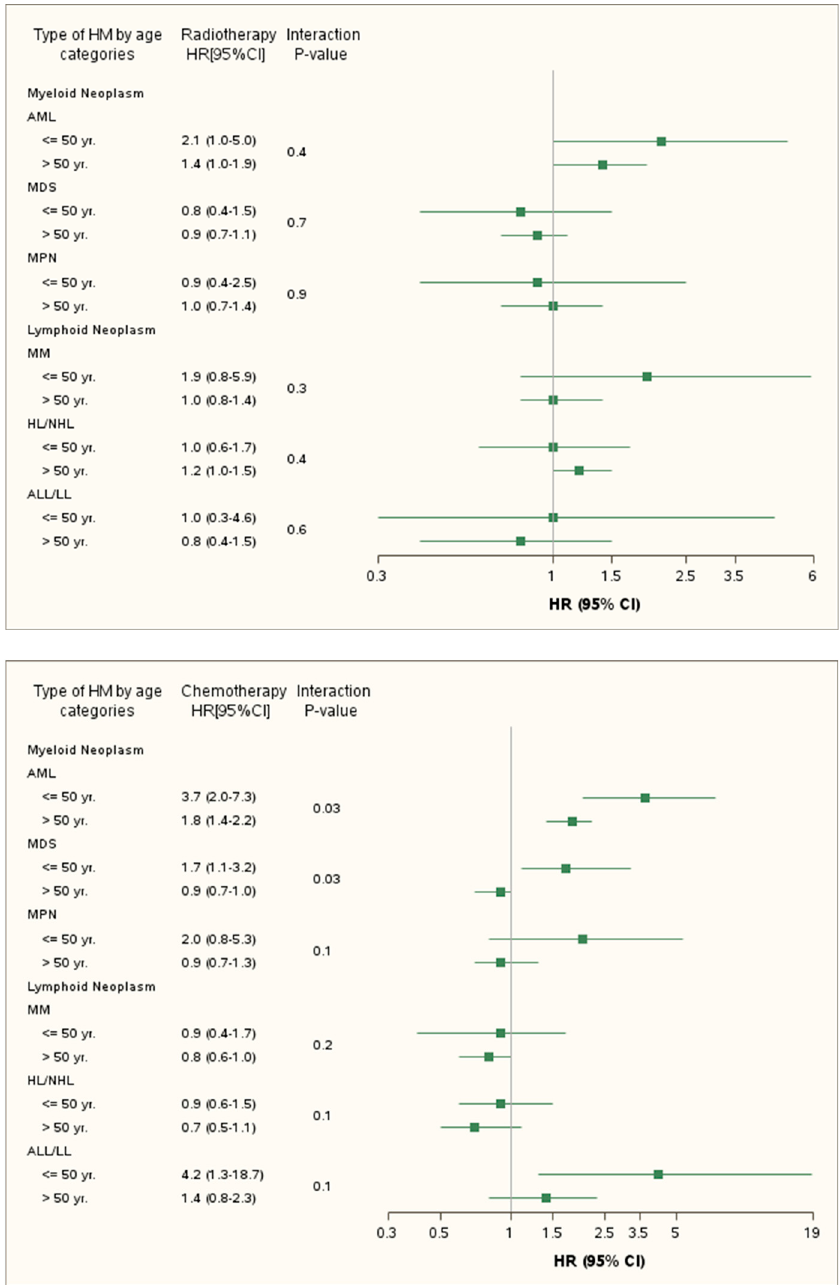
Figure 2. Risk of hematologic malignancies by age after chemotherapy and radiotherapy. Abbreviations: HM. Hematologic Malignancies; CI. Confidence Interval; AMl. Acute myeloid Leukemia; MDS. Myelodysplastic syndrome; MPN. Myeloproliferative Neoplasm; MM. Multiple Myeloma; HL/NHL. Hodgkin’s and Non-Hodgkin’s lymphoma; ALL/LL. Acute lymphoblastic leukemia lymphocytic lymphoma. *Chemotherapy HR: Adjusted hazard ratio in the multivariable Cox model adjusted for radiotherapy, hormonal therapy and baseline characteristics including age at inclusion. affiliation to complementary Universal health insurance. Year of inclusion. type of structure. severe alcoholism. heavy smokers. morbid obesity. immunosuppressant. hepatitis B & C. HIV. *Radiotherapy HR: Adjusted Hazard Ratio in the multivariable Cox model adjusted for chemotherapy, hormonal therapy and baseline characteristics including age at inclusion. a ffi liation to complementary Universal health insurance. Year of inclusion. type of structure. severe alcoholism. heavy smokers. morbid obesity. immunosuppressant. hepatitis B and C.